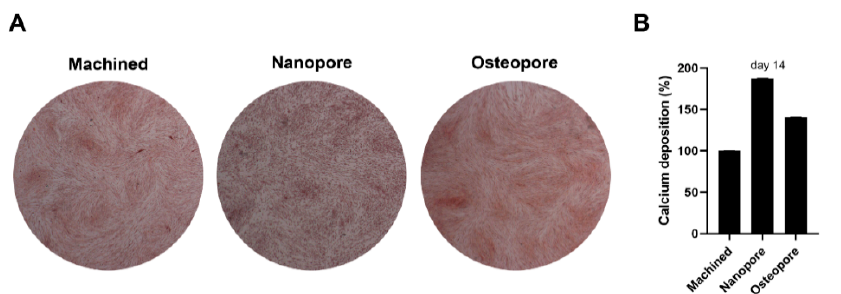
Figure 7. Effects of surface modifications on mineralization. ( A ) CaP enrichment sub-monolayers of Nanopore discs enhanced calcium deposition evaluated by alizarin red staining. Images were taken at magnification of 12 × by an inverted microscopy connected with a camera. ( B ) Quantitative measurement was performed with cetylpyridinium chloride. Data are expressed in relation to cell percentage cultivated on machined